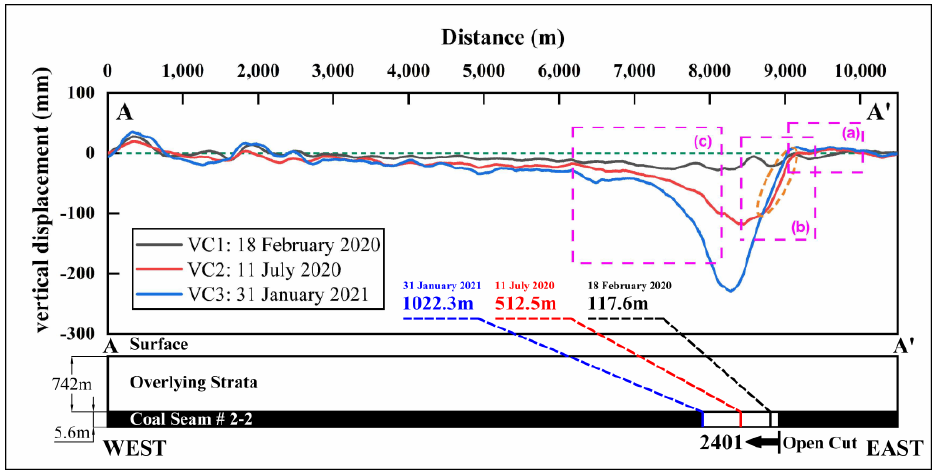
Figure 15. Cumulative vertical displacement curves on the profile line AA’. ( a ) is the area where ground uplift occurs directly above the open cut. ( b ) is the area where ground uplift occurs to the east of the open cut. ( c ) is the area where the overall ground subsidence occurs in front of the working